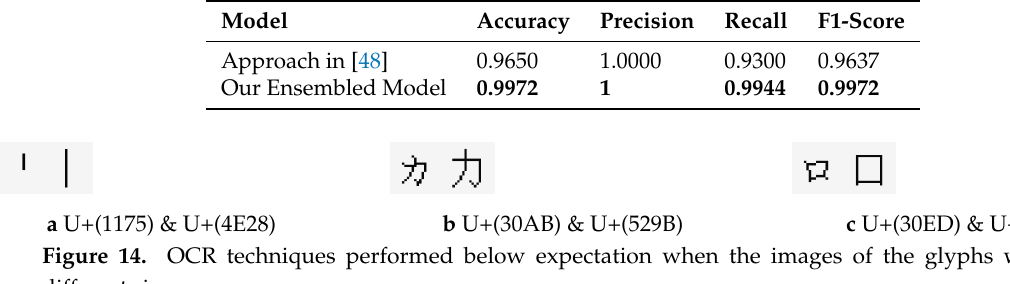
Figure 14. OCR techniques performed below expectation when the images of the glyphs were of different